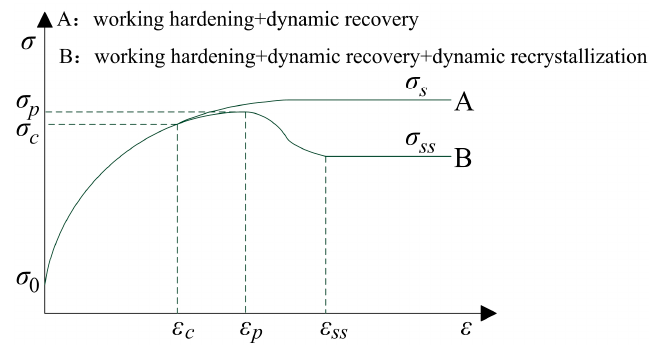
Figure 5. Typical flow stress curves for hot working.